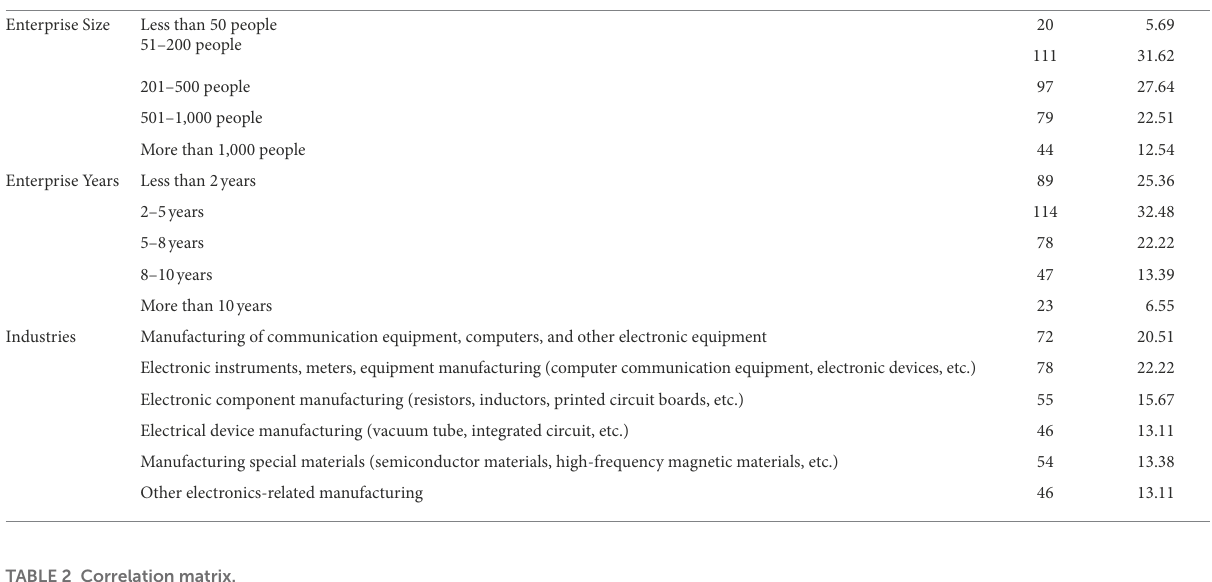
TABLE 2 Correlation